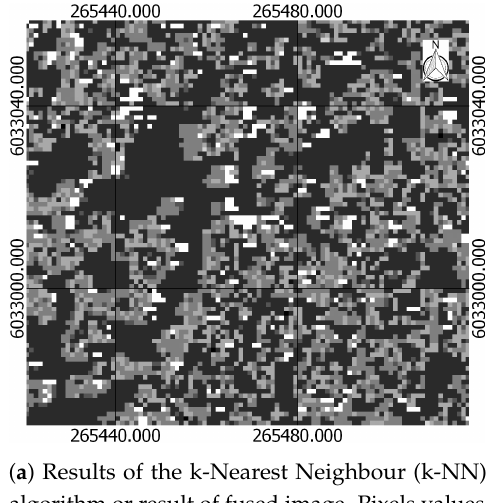
algorithm or result of fused image. Pixels values lie in the range of [0, 1], which corresponds to the possibility of a pixel to contain a dead tree.